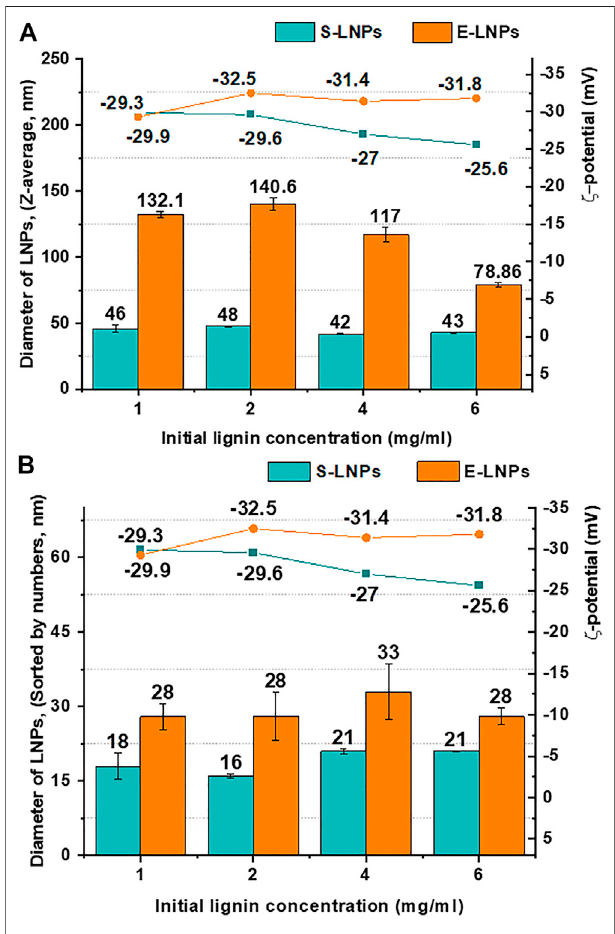
FIGURE2| E-LNPsizewaslargerthanthatofS-LNPs,andthesizewasnot dependent on LNP concentration. Shown are (A) Z-average sizes (d, nm) and ζ - potential(mV)and (B) LNPsizessortedbynumbers(nm)and ζ -potential(mV)ofthe S- and E-LNPs obtained from the corresponding lignin fractions at the initial lignin concentrations between 1 and 6 mg/ml. Despite small variations of ζ - potential for S-LNPs, their surface charge was lower than that for